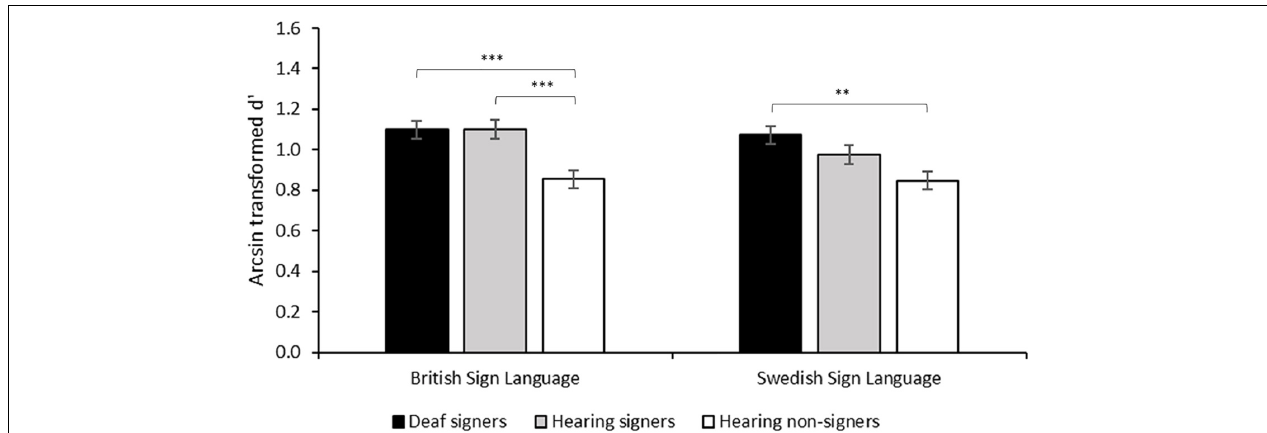
FIGURE 2 | Working memory performance with British Sign Language (BSL) and Swedish Sign Language (SSL) stimuli by British Deaf Signers (DS), Hearing British Signers (HS) and Hearing British non-signers. The y -axis shows arcsin transformed d (cid:48) collapsed across load. D (cid:48) is based on hits adjusted for false alarms in accordance with signal detection theory, and the arcsin transformation was used because of near ceiling performance at n = 1. Reprinted with the publisher’s permission from Rudner et al. (2016b).